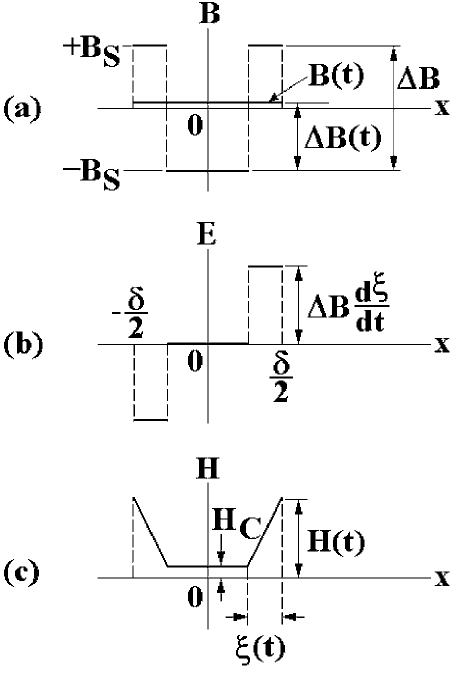
FIG. 3. Field distribution in the (cid:1) -thick iron tape with rectan- gular hysteresis loop at some fixed time t , when H ð t Þ > H C